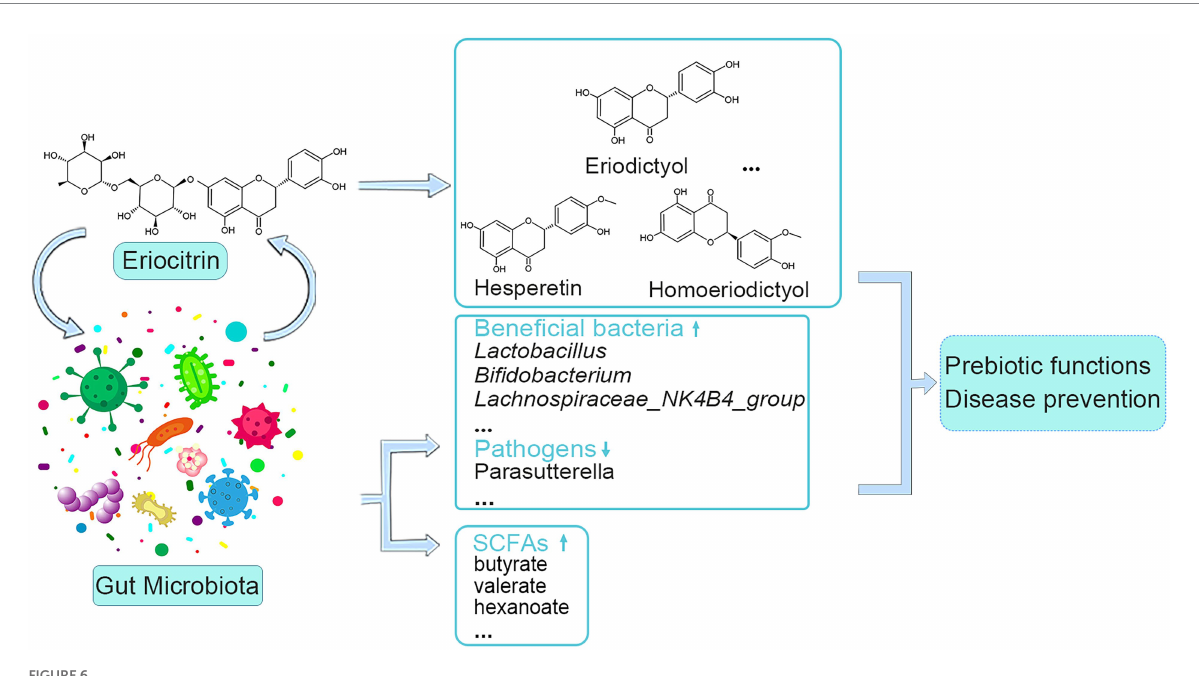
FIGURE 6 Schematic of interactions between eriocitrin and the gut